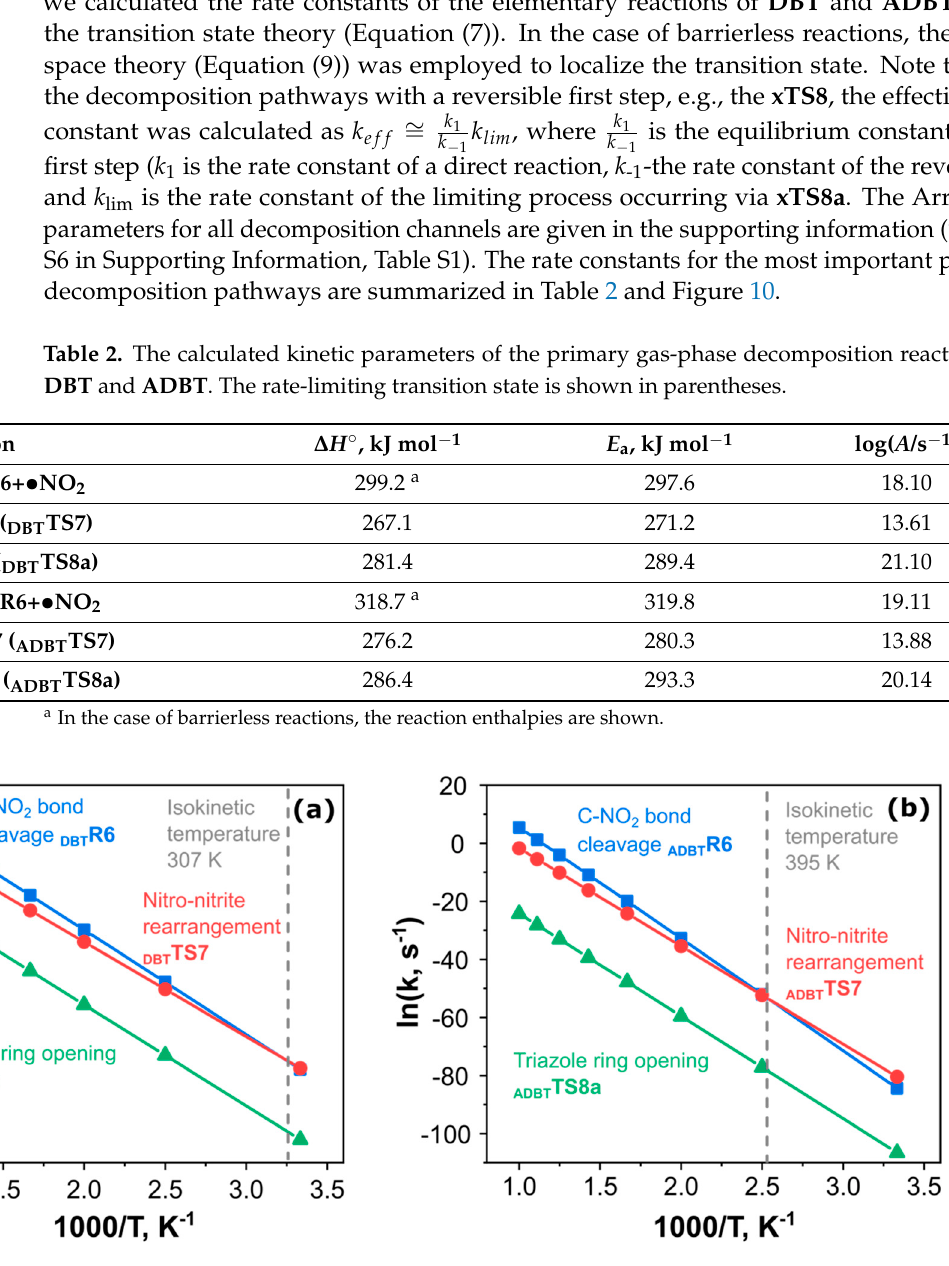
Table 3. Thermal stability of the dinitrobenzotriazoles and dinitrotriazolopyridines: the effective rate constants of C–NO 2 bond scission.